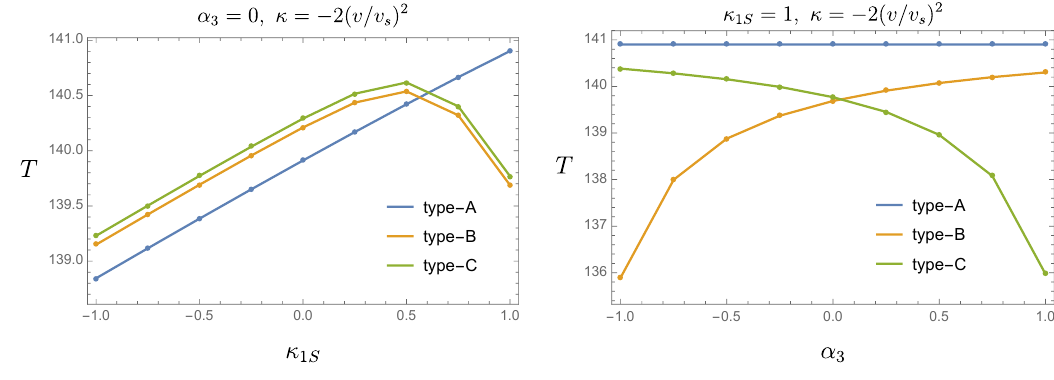
Figure 5 . String tensions of the type-A, type-B and type-C strings. The parameters are taken as eq. (3.51) and the tension is calculated by integration over 0 ≤ r ≤ 120 v − 1 0 and κ 1 S is taken as a free parameter. The tension of the type-A string increases as κ 1 S becomes larger, but those of the type-B and type-C ones change to decrease for κ 1 S & 0 . 5 . (right): κ 1 S is fixed as 1 . 0 and α 3 is taken as a free parameter. As is expected, the tension of the type-B (type-C) strings decreases (increases) as α 3 becomes larger. The type-C string becomes the lightest one for α 3 & 0